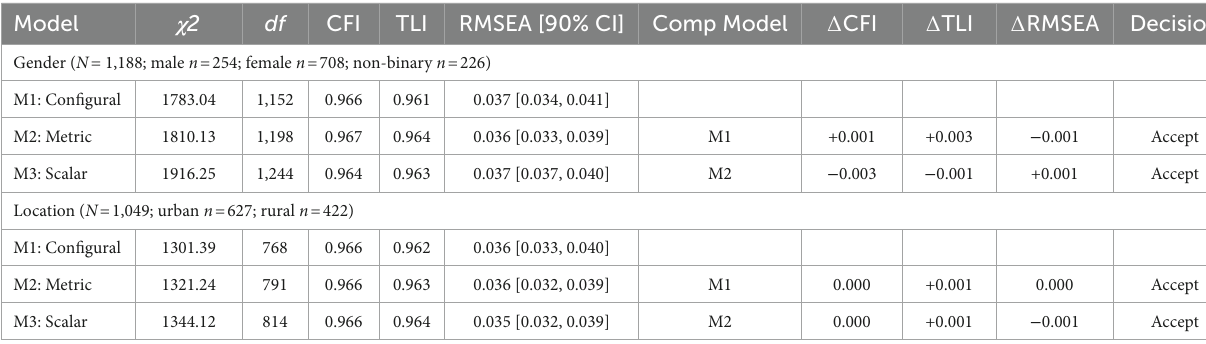
TABLE 3 Measurement invariance of the Gender Climate Scale.